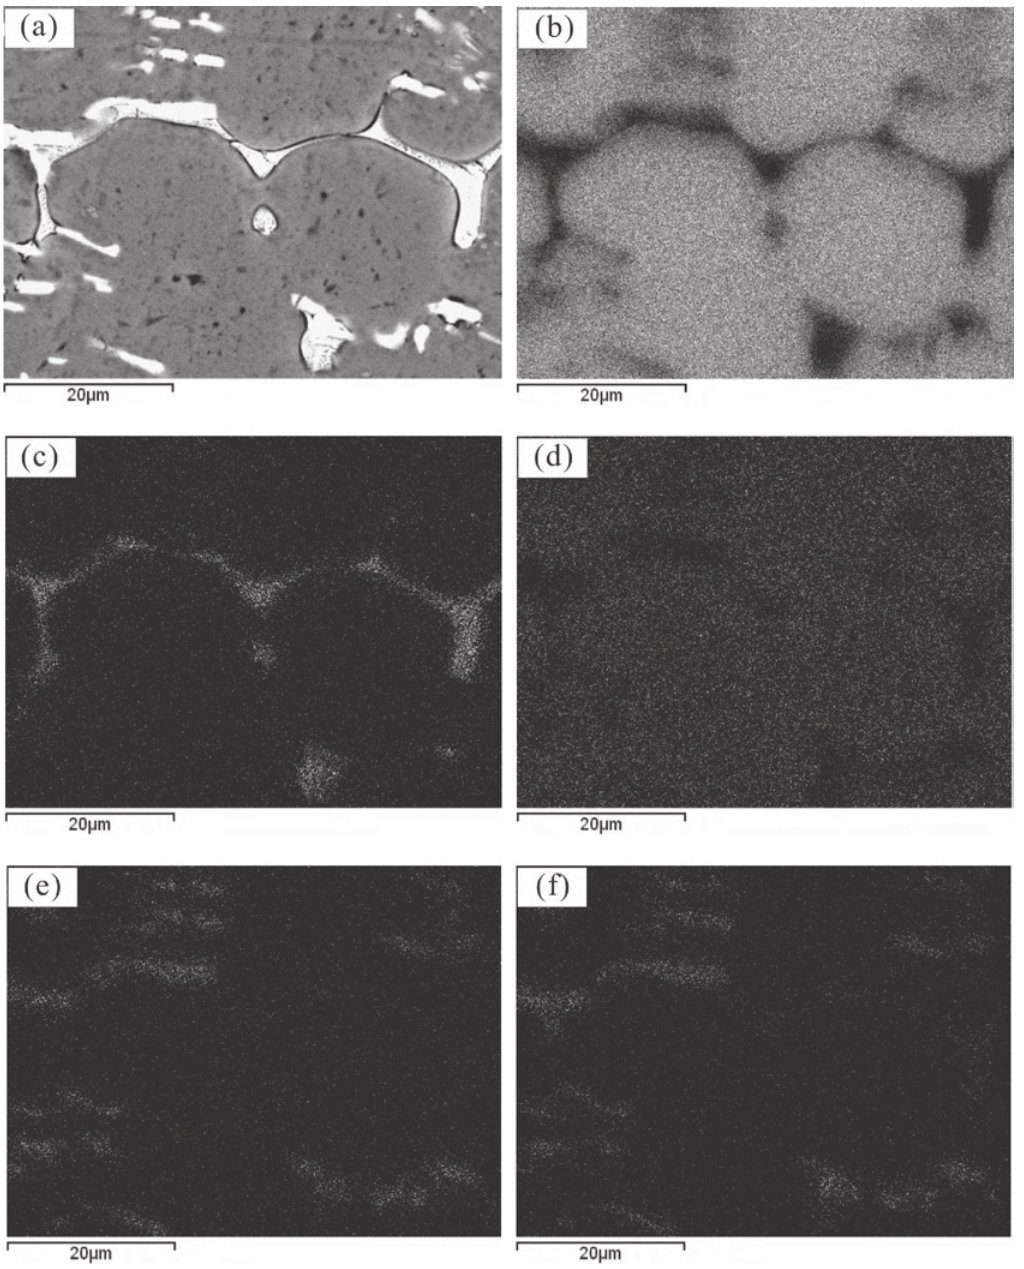
Fig. 2: SEM microstructure of as-cast alloy 2618 and elements distribution: (a) SEM microstucture; (b) Al; (c) Cu; (d) Mg; (e) Fe; (f)